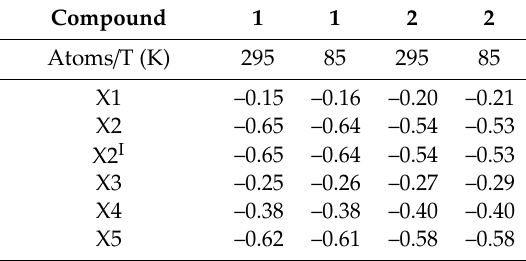
Table 4. Residual δ charges on the X atoms for 1 (X = Cl) and 2 (X = Br) at 295 and 85 K.